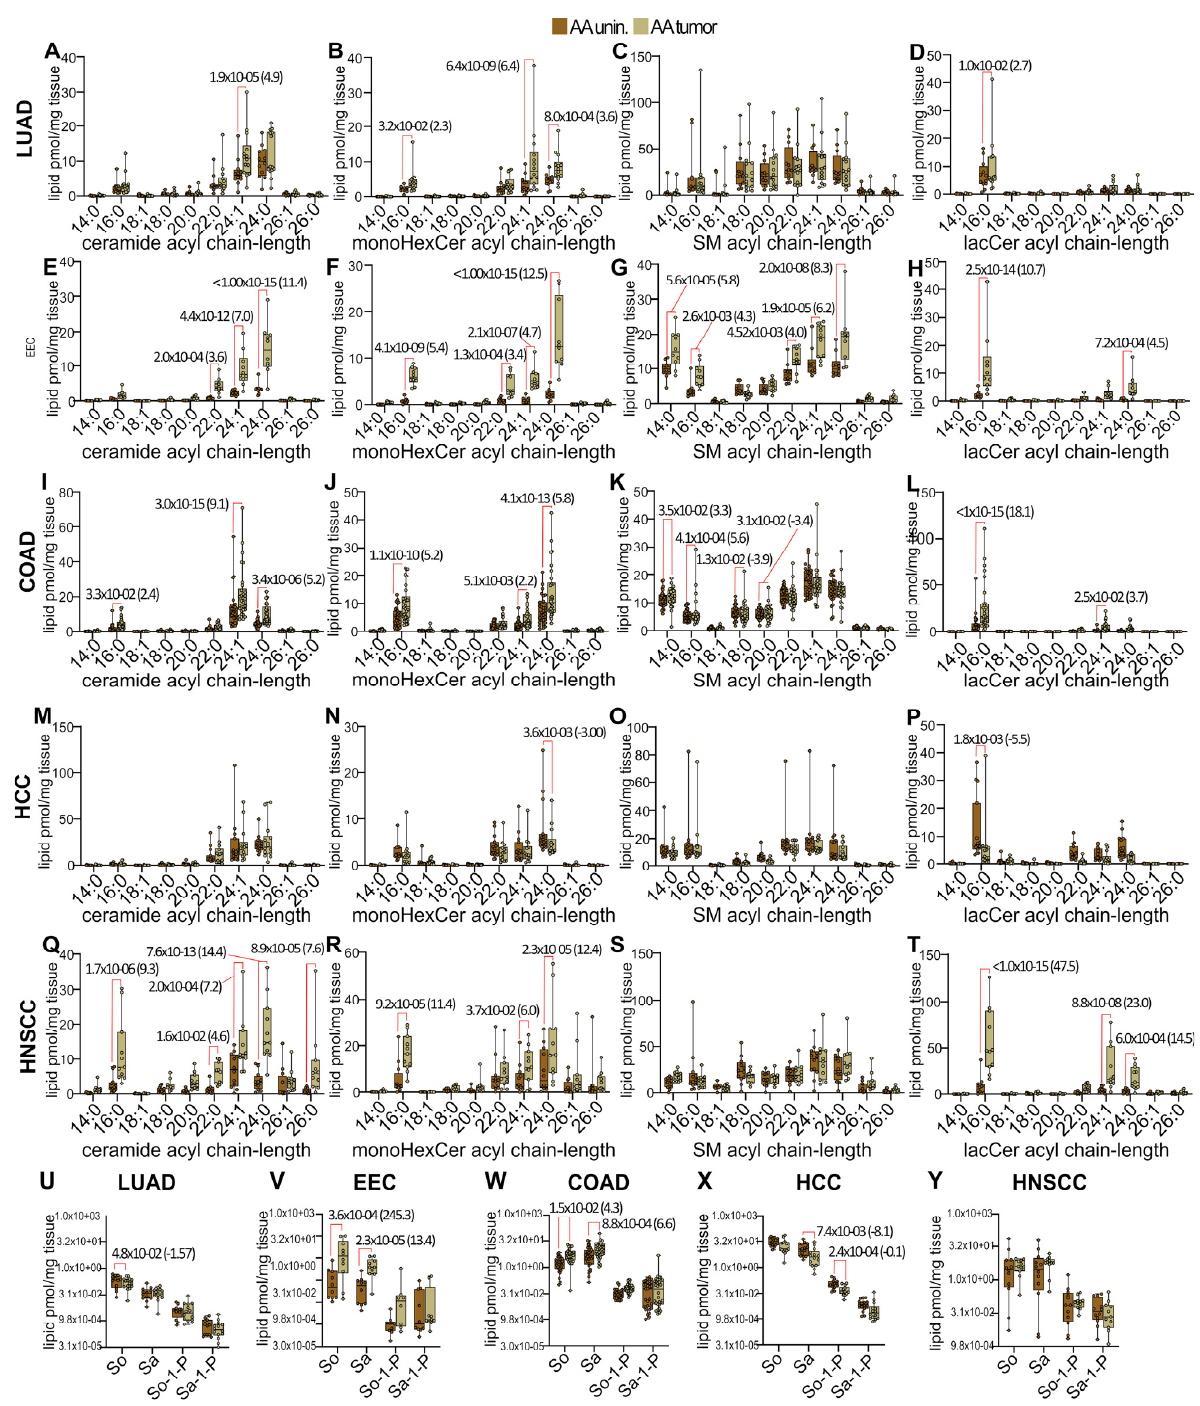
Figure 2. Sphingolipid profiles of normal adjacent uninvolved tissues and tumors of self-identified AA males diagnosed with LUAD, COAD, HCC, and HNSCC and of self-identified AA females with EEC. The indicated chain-length sphingolipids were quantified by LC-ESI-MS/MS in normal adja- cent uninvolved tissues (unin.) and tumors of self-identified AA subjects with primary histopatho- logic confirmed diagnoses of lung adenocarcinoma (LUAD; panels ( A – D , U )), endometrial endome- troid carcinoma (EEC; panels ( E – H , V ), colorectal adenocarcinoma (COAD; panels ( I – L , W )), hepa- tocellular adenocarcinoma (HCC; panels ( M – P , X )), and head and neck squamous cell carcinoma (HNSCC; panels ( Q – T , Y )). Lipid levels are shown as the amount of picomoles of indicated chain length and lipid species per mg of tissue. For LUAD, unin. n = 12, tumor n = 14; EEC, n = 10; COAD,